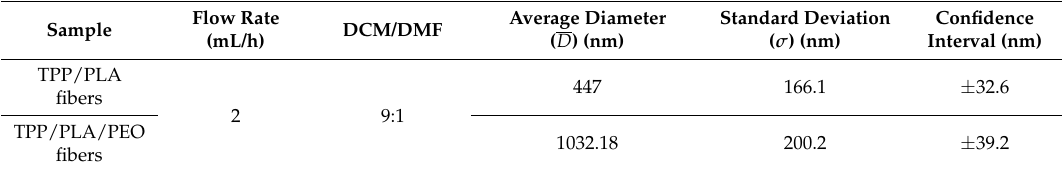
Table 2. Average diameters of TPP loaded non-core-shell fibers.